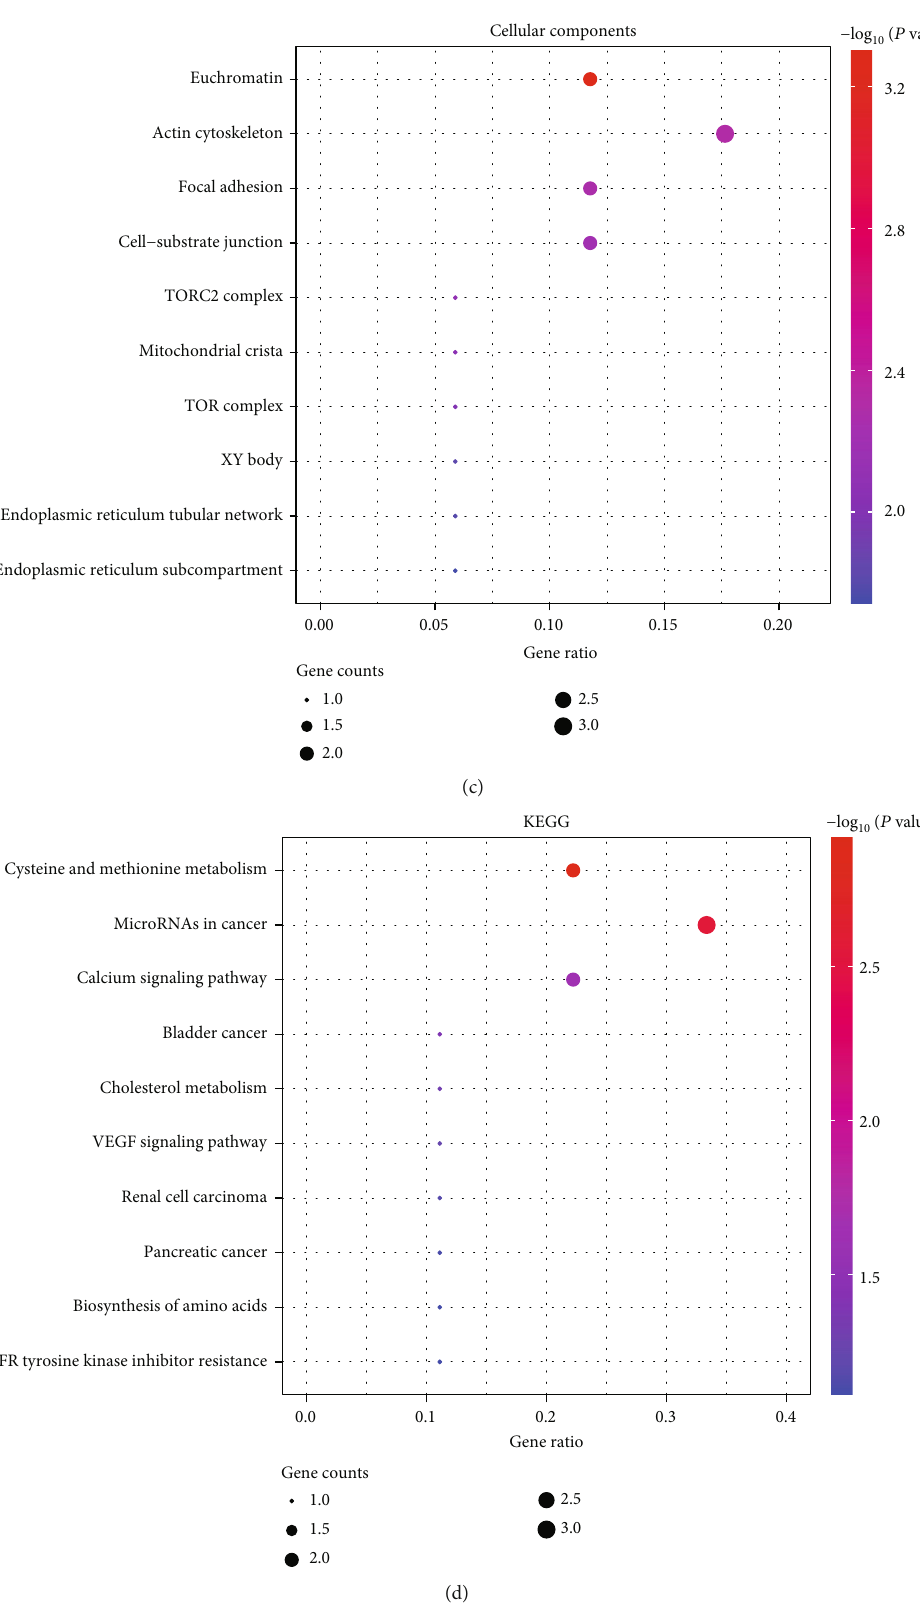
Figure 5: Functional enrichment analyses of the mRNAs in ceRNA network. (a) – (c) The top 10 enriched BP (a), MF (b), and CC (c) of mRNAs in ceRNA network. (d) The KEGG pathway analysis of mRNAs in ceRNA